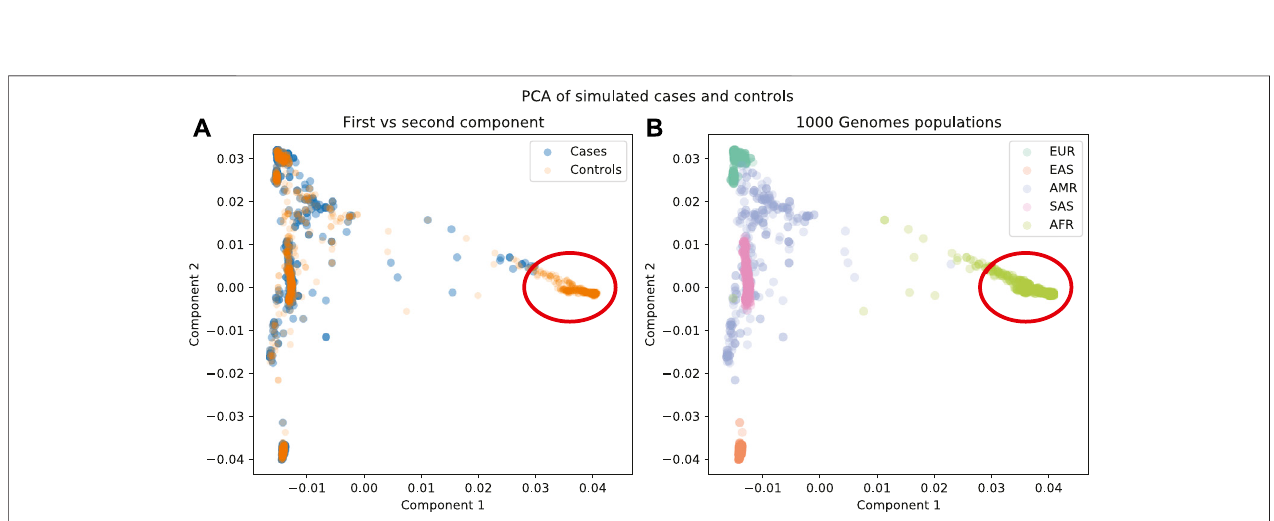
FIGURE6|(A) First componentsplottedforcases and controls. (B) First components plottedfor1000Genomespopulationlabels. There isaregion inthese data that is not well represented in the cases as well as in the controls (red circle).